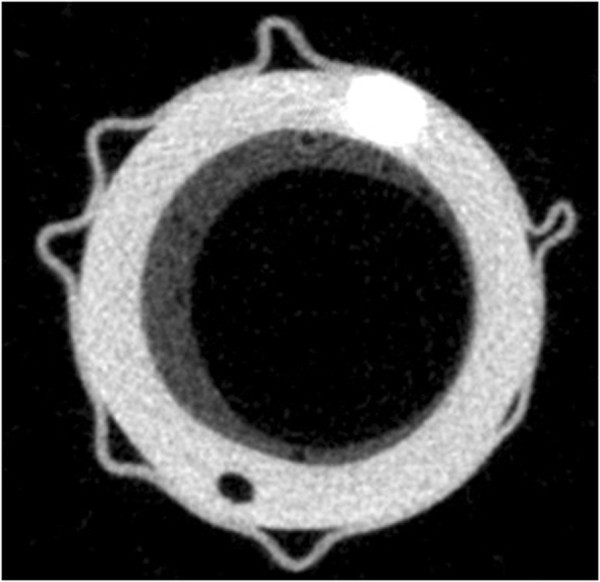
Exemplary ETT section obtained by MicroCT scan. Representative image obtained by MicroCT scan of an ETT collected after 10 days of intubation. The abundant secretions layer (dark grey,) is adherent to the plastic material of the ETT (light grey) in the area below the cuff.